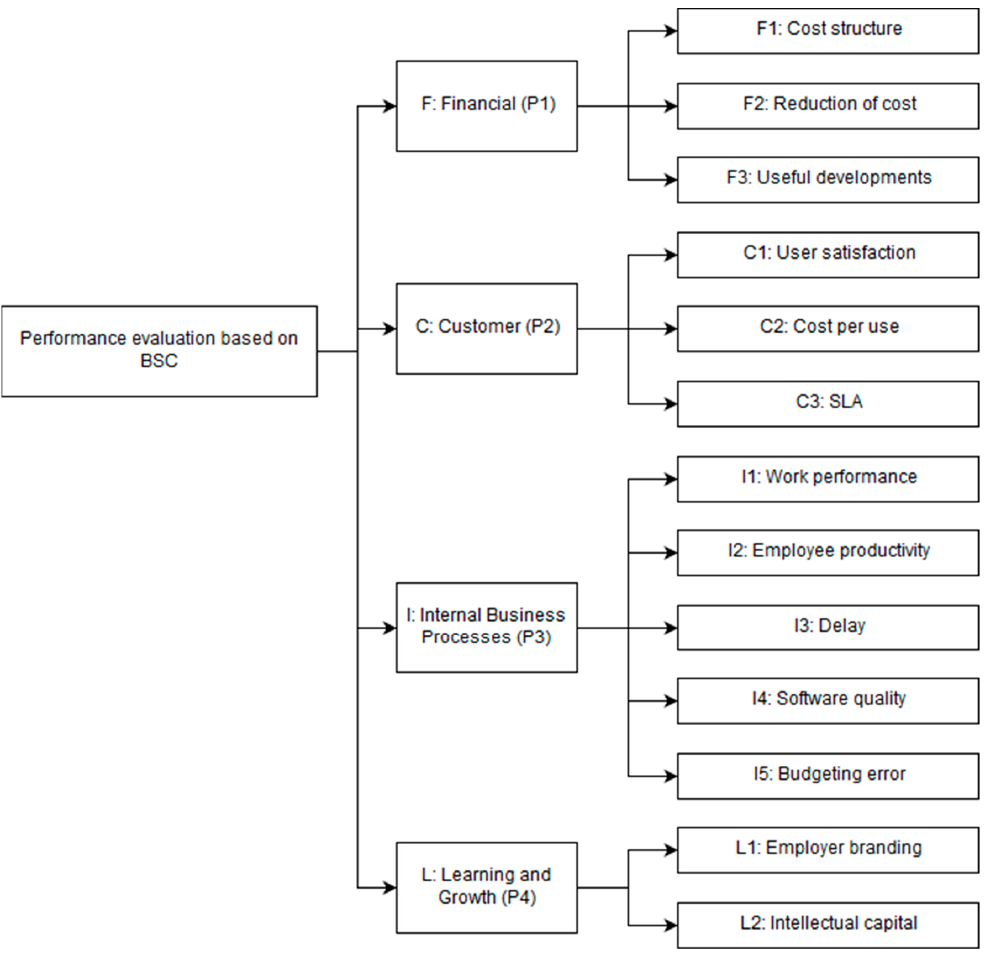
Figure 2. Hierarchical framework of Balance Scorecard (BSC) performance evaluation criteria for a Financial Software Factory (FSF). Adapted from [27,53].